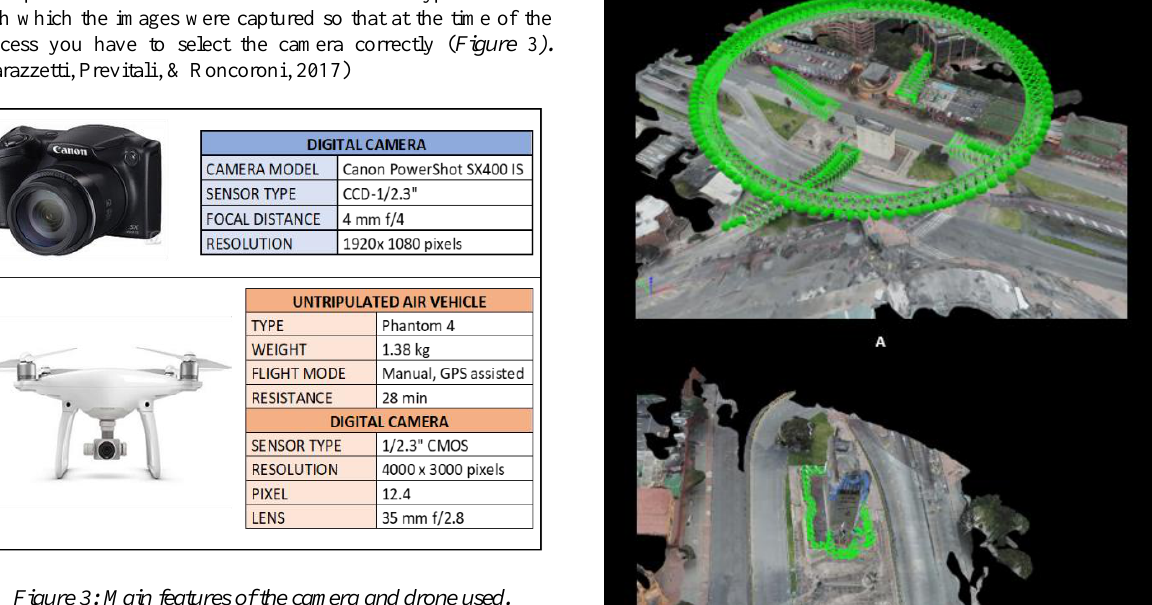
Figure 3: Main features of the camera and drone used. Own Source.